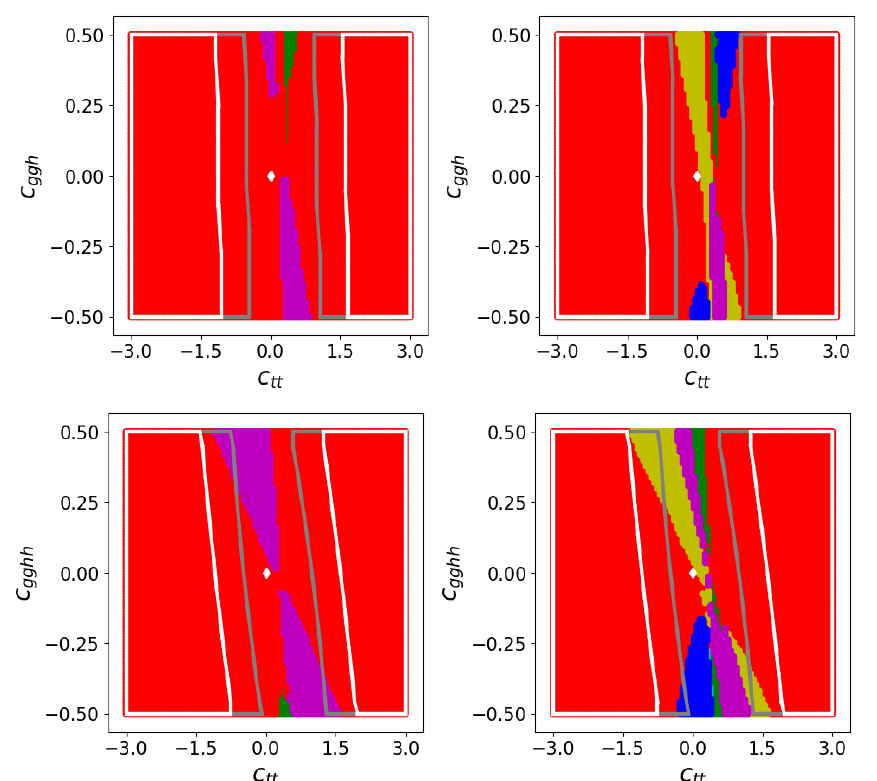
Figure 15 . Shape types produced by variations of c tt versus c ggh (top) and c gghh (bottom). Left: 4 clusters, right: 7 clusters. The areas outside the silver and white curves are regions where the total cross section exceeds 6 : 9 (cid:2) (cid:27) SM and 22 : 2 (cid:2) (cid:27) SM , respectively. These values are motivated